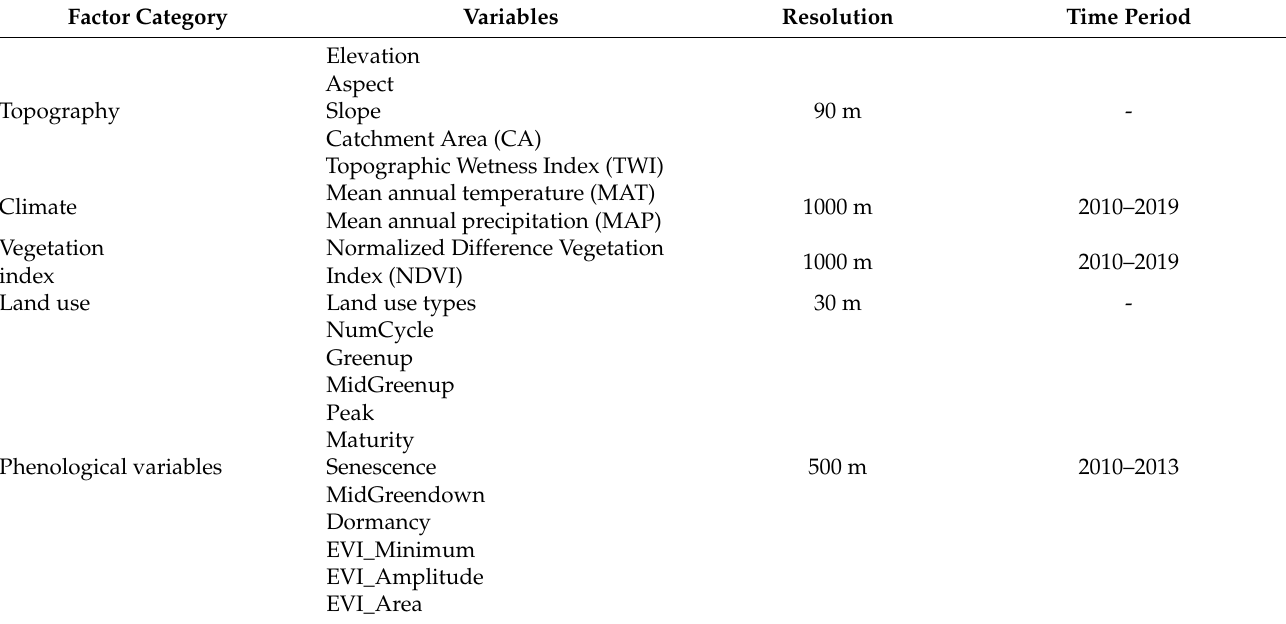
Table 1. Information of environmental variables in the study